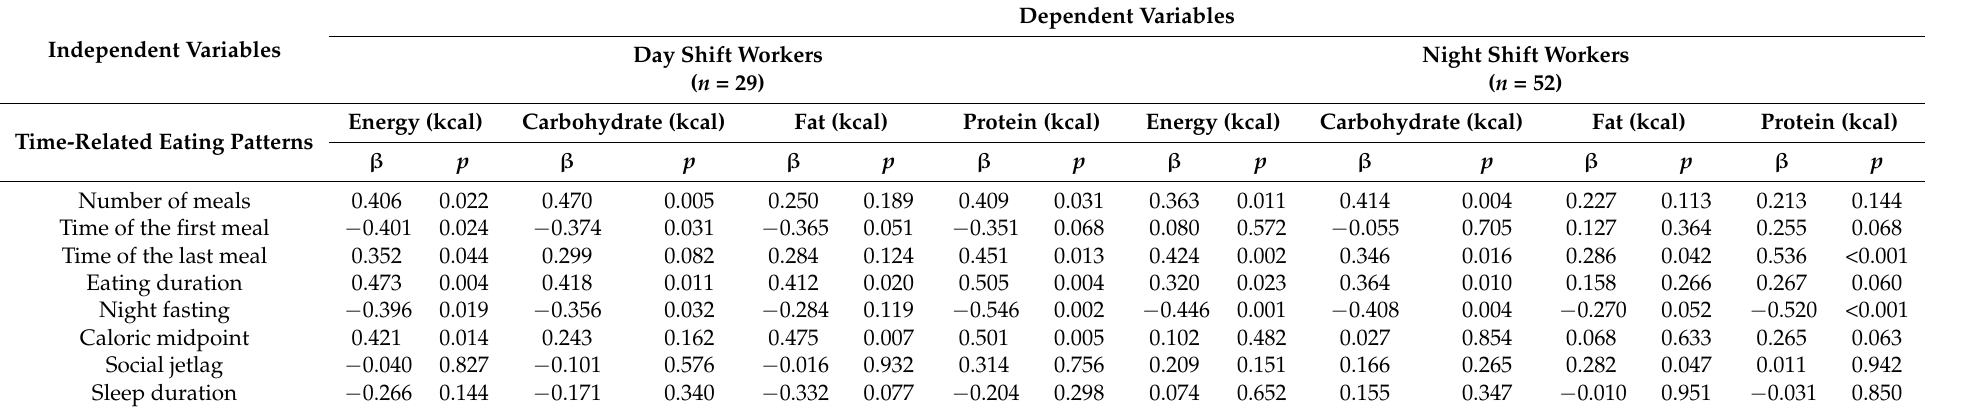
Table 4. Association between time-related eating patterns and daily food consumption between day and night shift